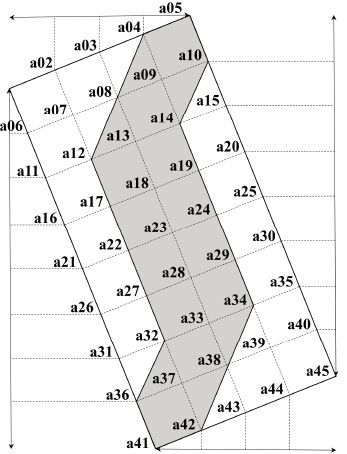
Figure 3. The method for extracting the final overlap area for any two adjacent